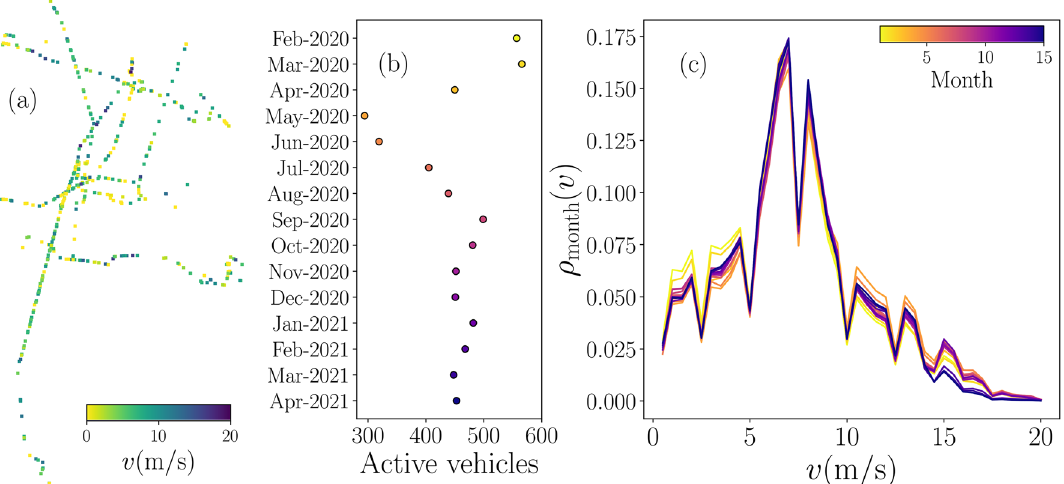
Figure 1. Global characteristics of the BRT system Metrobús in Mexico City. ( a ) Activity of vehicles at 13:00 h observed in registers on March 2nd, 2020. Each active vehicle in the system is represented by a point with speeds v encoded in the color bar. ( b ) Monthly active vehicles from February 2020 to April 2021. ( c ) Probability density ρ month ( v ) of the speed v of active vehicles for each month in the color bar [the same colors are shown in the results in panel ( b )]. We consider bin counts with increments � v = 0.25m / s . All figures were created using python 3.8 and the matplotlib (3.4.3) package (https:// matpl otlib.